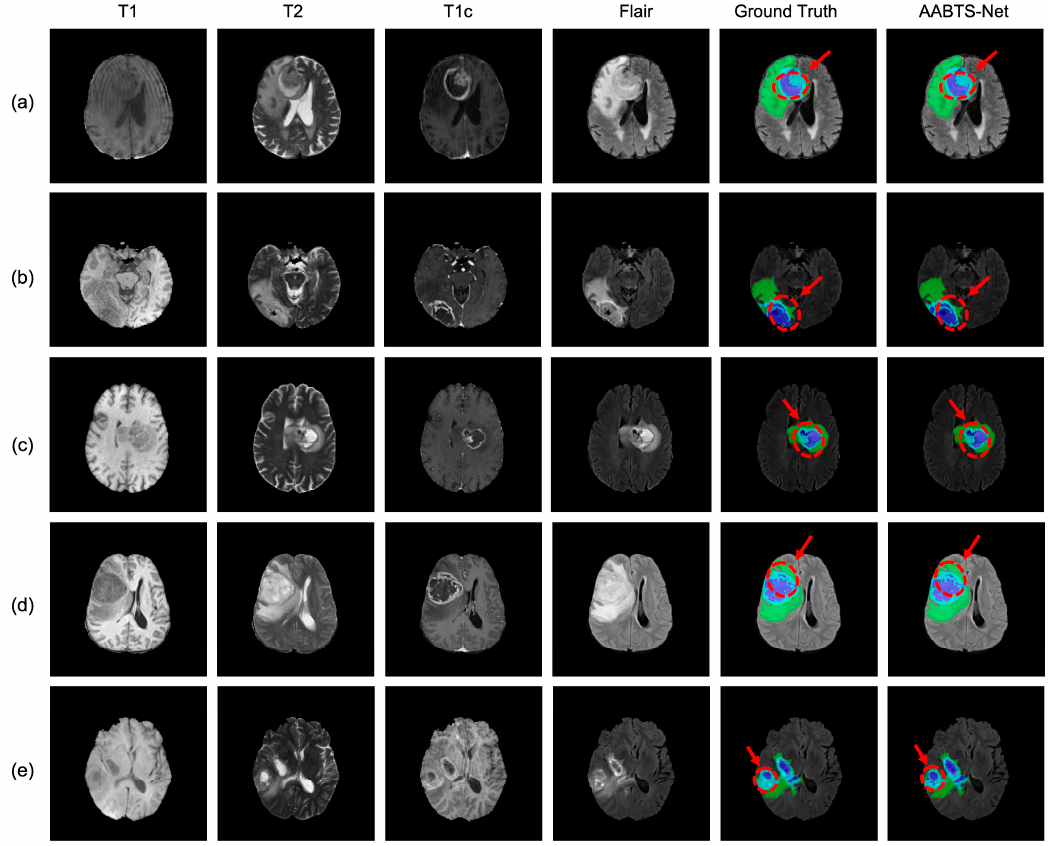
Figure 5. The visualized segmentation results of the proposed AABTS-Net. ( a – e ) represents different visualized cases. From left to right: T1, T2, T1c, Flair, Ground truth and the result segmented by AABTS-Net.